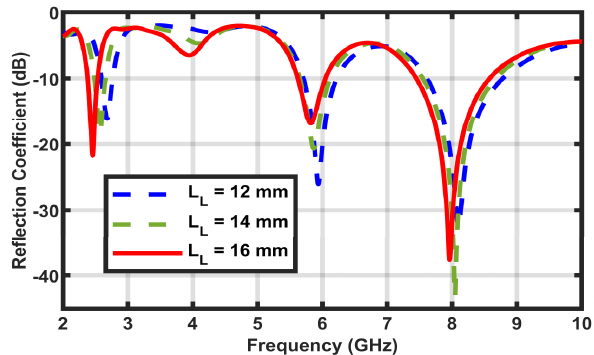
Figure 4. Effect of varying the length of the ground plane.